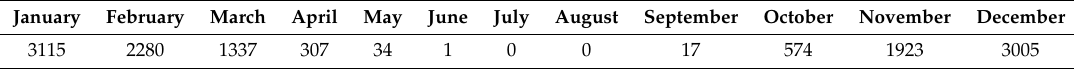
Table 1. Total monthly heat demand of Walheim in MWh.